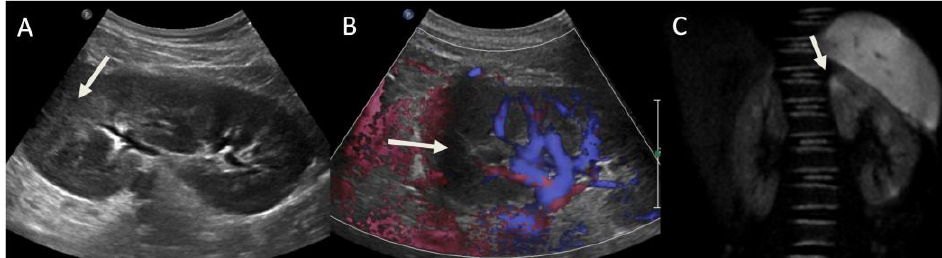
Figure 4. ( A ) US with color Doppler shows an area of hyperechoic parenchyma in the superior pole (arrow); ( B ) in the same area, a reduction of vascularization of color Doppler can be appreciated (arrow). ( C ) DWI shows multiple areas of restricted diffusion, in particular in the superior pole, where US alterations were detected (arrow).